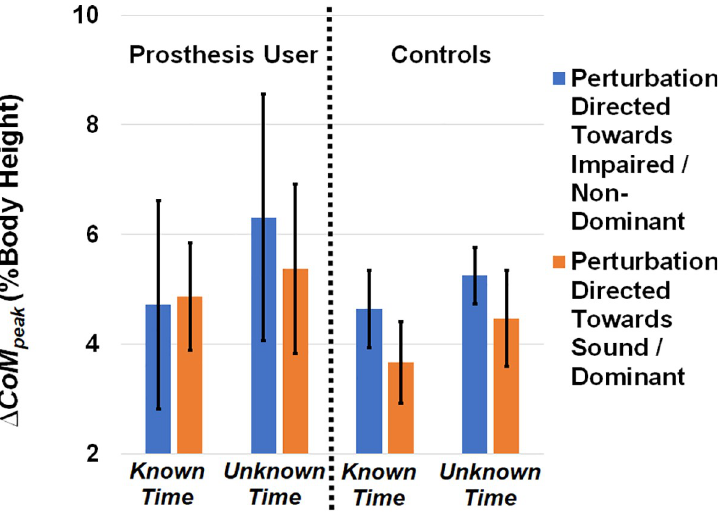
Fig 4. Average maximum CoM displacement ( Δ CoM peak ) separated by group, perturbation direction, and perturbation timing knowledge. The main effect of timing knowledge was significant (p = 0.010), with less displacement when perturbation timing was known. Error bars denote 95% confidence intervals.